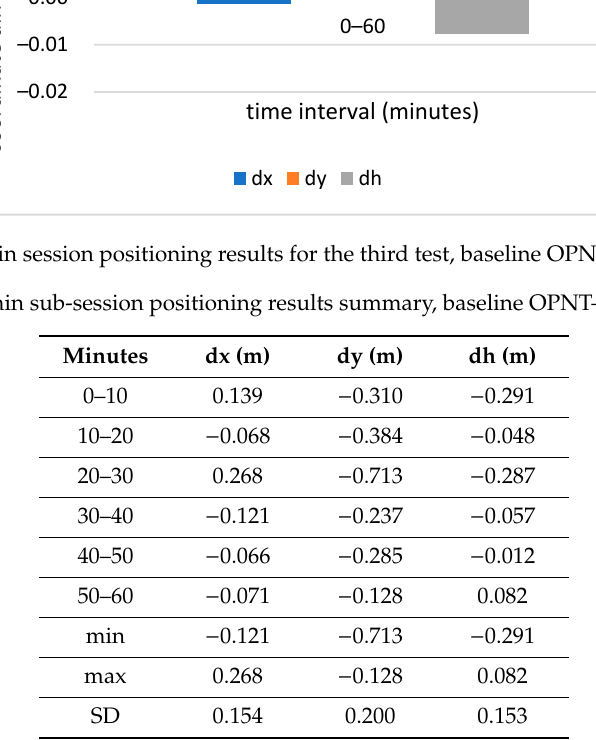
Table 12. 15 min sub-session positioning results summary, baseline OPNT–P30Pro (4 km).